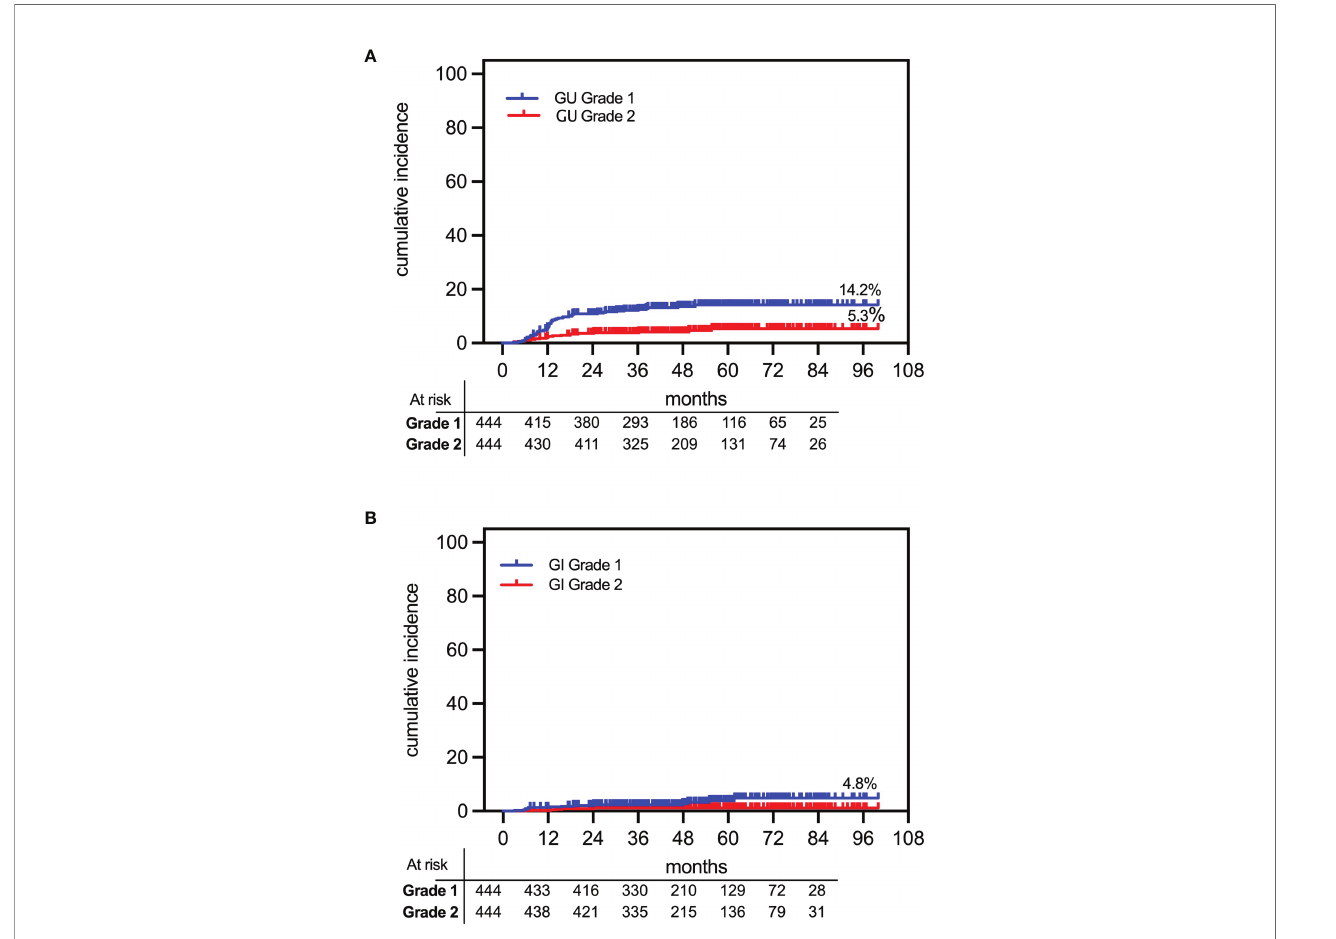
FIGURE 8 | Cumulative actuarial incidence of OAR toxicities following rectal distension-mediated 5 × 9 Gy SABR. The 7-year late grade 1 and 2 toxicities are shown for (A) urinary (GU) and (B) bowel (GI)